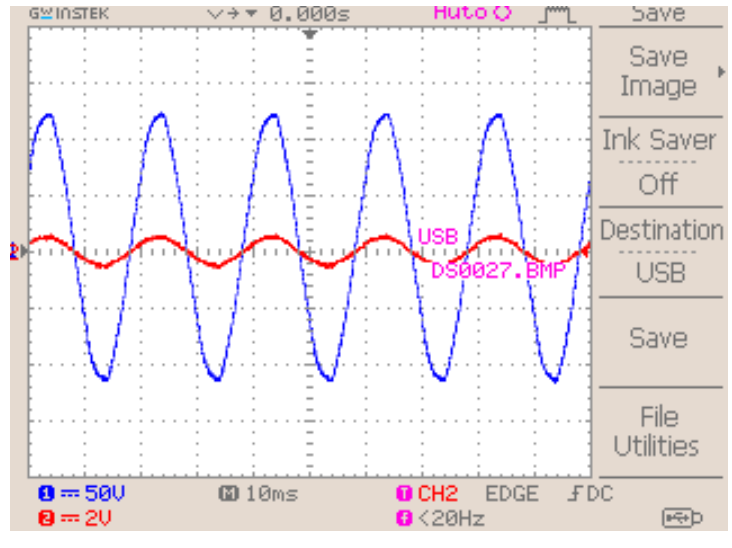
Figure 18. Source voltage and source current.